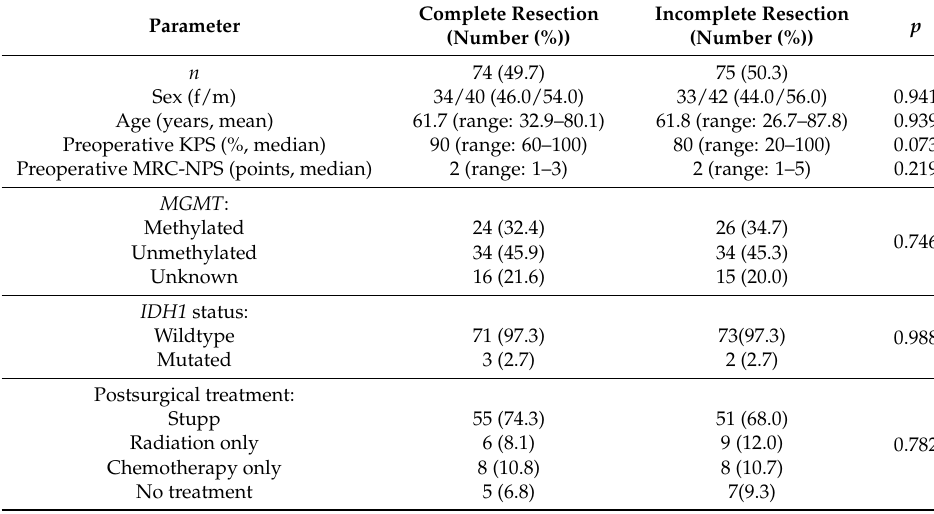
Table 2. Baseline characteristics of patients with GBM who underwent complete (EOR: 100%) or incomplete resection (EOR <